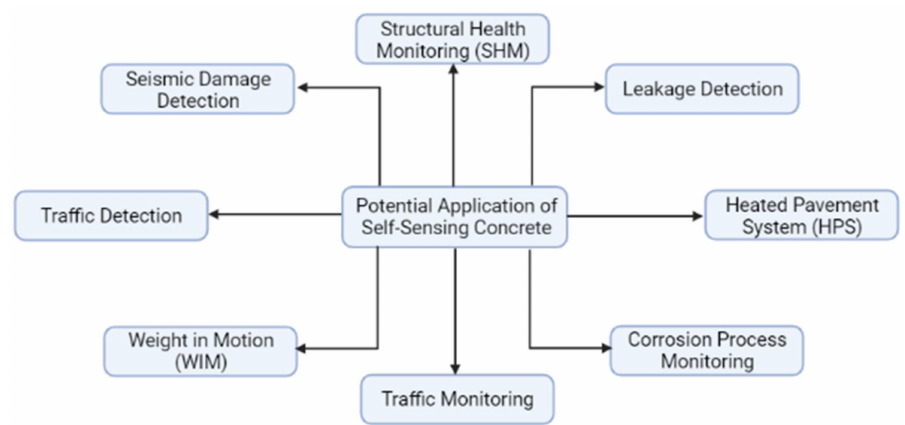
Figure 31. Potential fields of